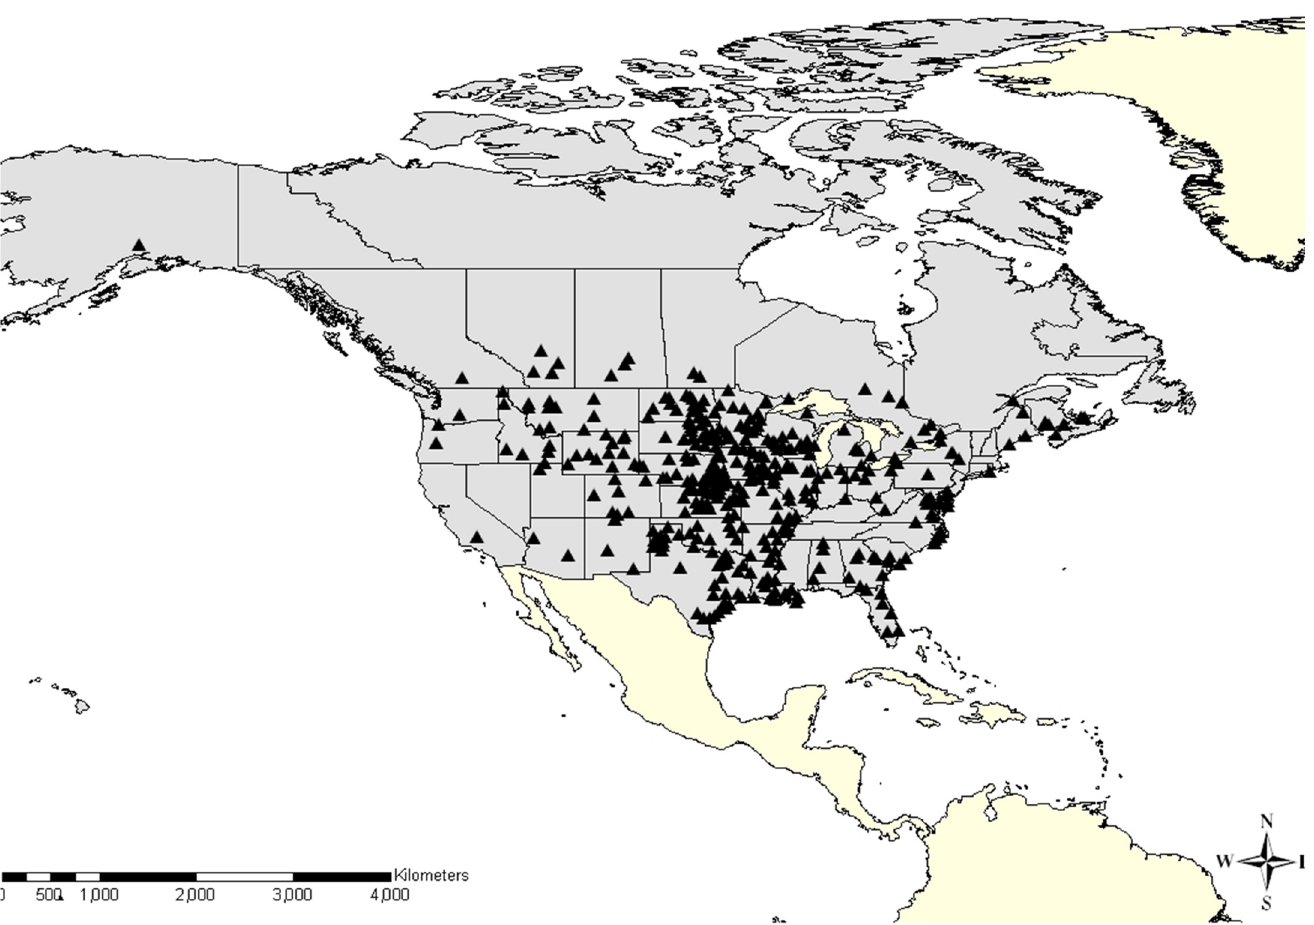
Fig 1. Locations of capture sites of Blue-winged Teal sampled for low pathogenic avian influenza virus across Canada and the United States, from 2007 to 2010.